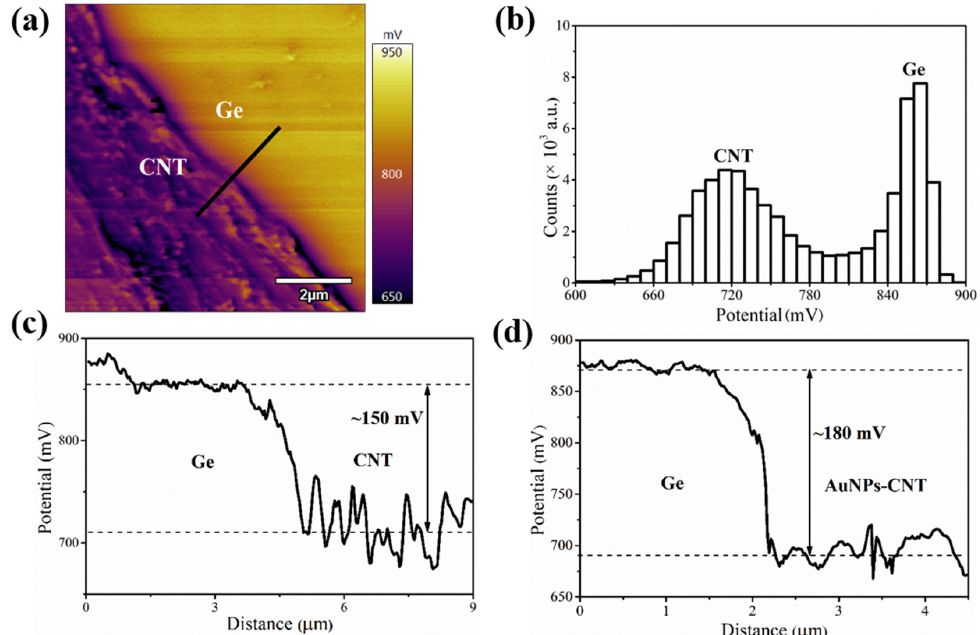
Figure 4. The surface potential of the SWCNT/Ge heterojunction before and after AuNPs modification. ( a ) The SKPM measurements of the surface potential distribution for the SWCNT/Ge heterojunction. ( b ) Pixel-wise histogram of the surface potential distribution measurements for the SWCNT/Ge heterojunction. The CPD of ( c ) the pristine and ( d ) the AuNPs-modified SWCNT/Ge heterojunction.